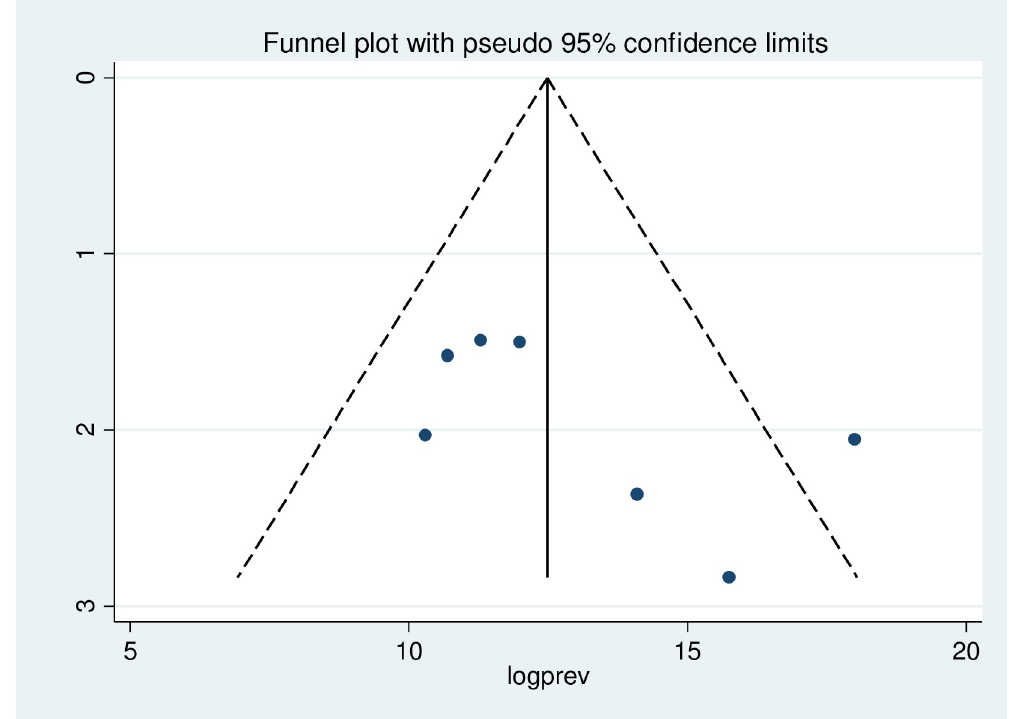
Fig 5. Funnel plot to test publication bias of the 7